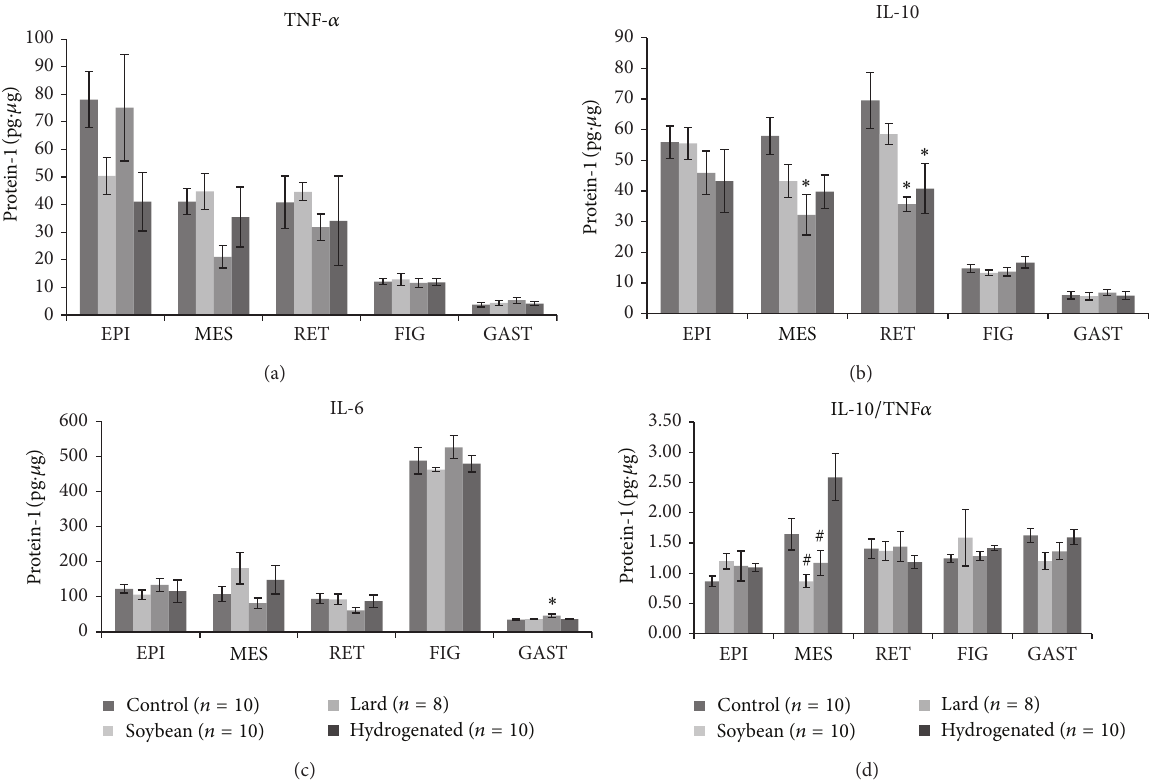
Figure 1: Cytokines levels (IL-6 (pg/ug protein-1) in adipose tissue depots, liver, and gastrocnemius muscle of studied mice groups—(C) control group, (S) soybean, (L) lard, and (H) hydrogenated vegetable fat groups. (a) Tumoral necrosis factor alpha (TNF- 𝛼 ), (b) interleukin- 10 (IL-10), (c) interleukin-6 (IL-6), and (d) IL-10/TNF- 𝛼 ratio. ∗ Values significantly different from (C) group at 𝑃 < 0.05 . # Values significantly different from (H) group at 𝑃 < 0.05